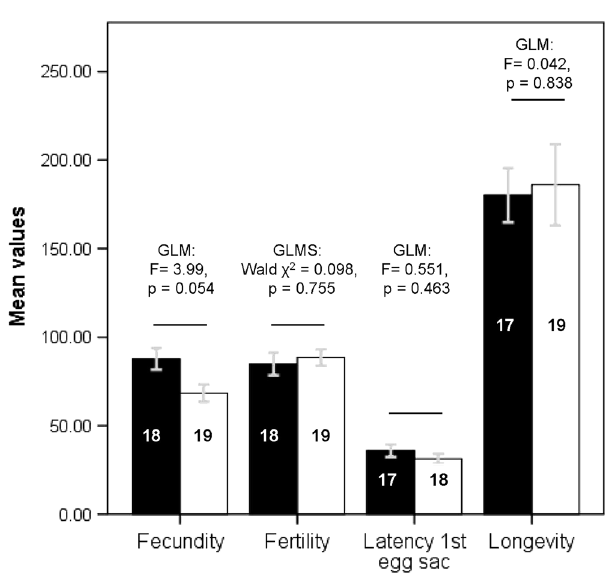
Figure 3. Mean ( ± s.e.) of female fecundity (number of eggs produced), fertility (% of eggs that hatch, note that the maximum value is 100), latency to produce the first egg sac (days) and longevity (days) for immature mated females (IM, white bars) and adult mated females (AM, black bars). Statistics above each pair of bars show the results of comparisons of IM and AM females within each category (GLM = general linear model; GLMS = generalized linear